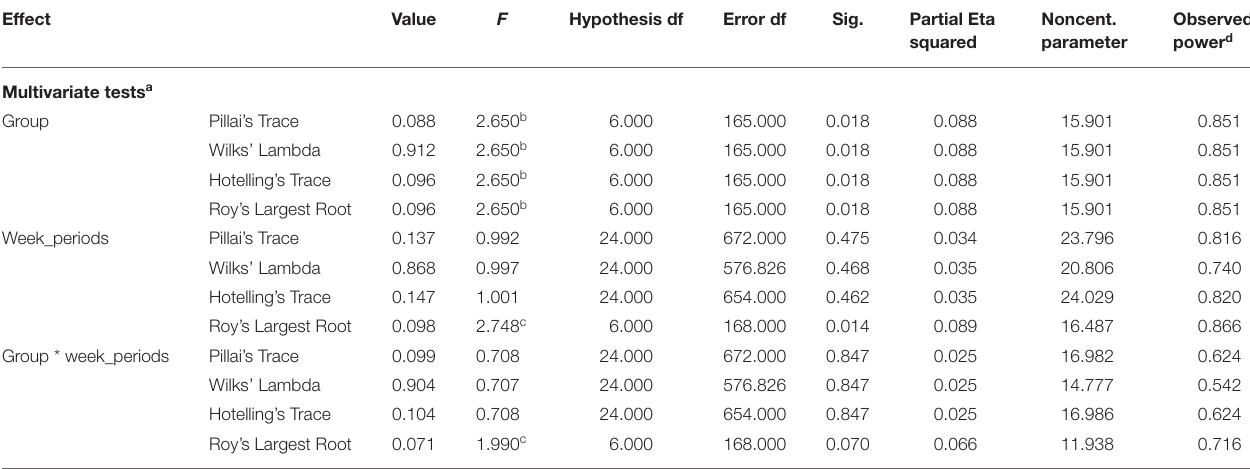
Noncent. Observed squared parameter power d